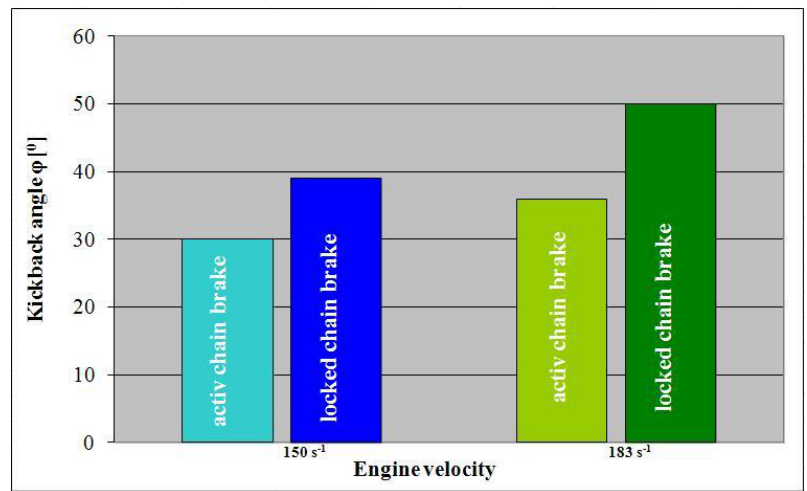
Figure 13. Effects of hand brake on chainsaw kickback angle; maximum calculated final uncertainty of the kickback angle was ±2°.